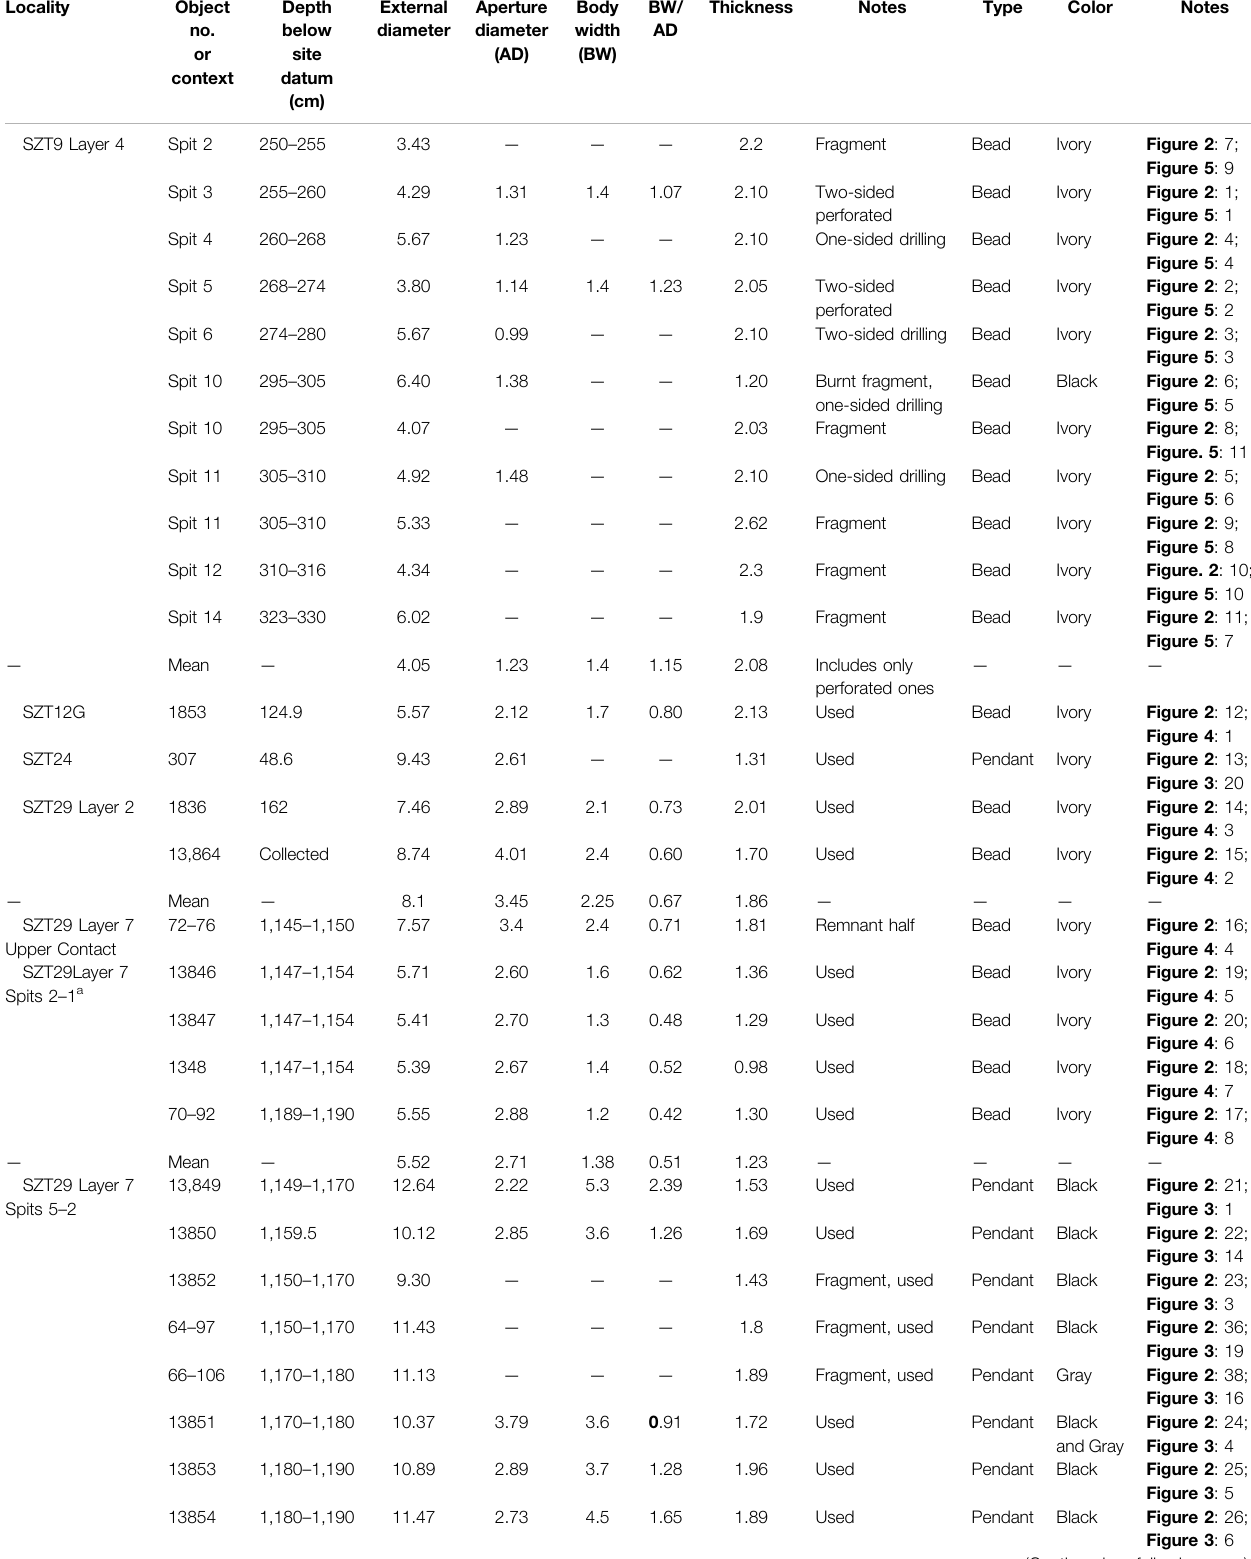
Figure 2 : 7; Figure 5 : 9 Figure 2 : 1; Figure 5 : 1 Figure 2 : 4; Figure 5 : 4 Figure 2 : 2; Figure 5 : 2 Figure 2 : 3; Figure 5 : 3 Figure 2 : 6; Figure 5 : 5 Figure 2 : 8; Figure. 5 : 11 Figure 2 : 5; Figure 5 : 6 Figure 2 : 9; Figure 5 : 8 Figure. 2 : 10; Figure 5 : 10 Figure 2 : 11; Figure 5 : 7